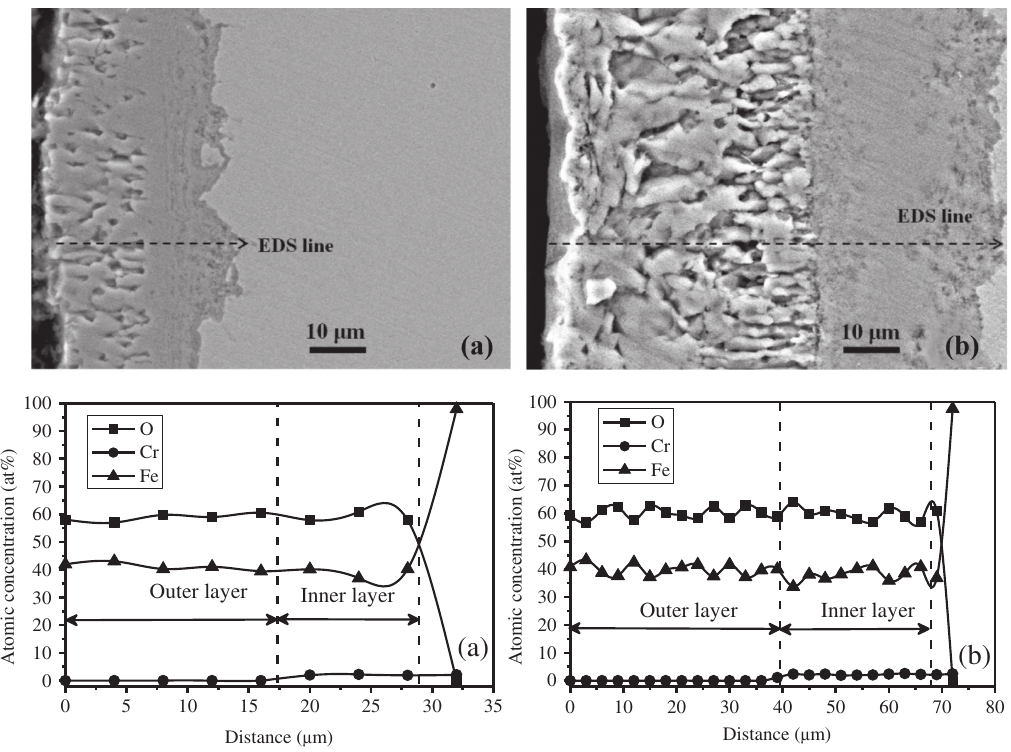
Figure 8: The cross-sectional images and EDS profiles of the oxides exposure to SCW for 1000 h. (a) 540°C, (b) 600°C.